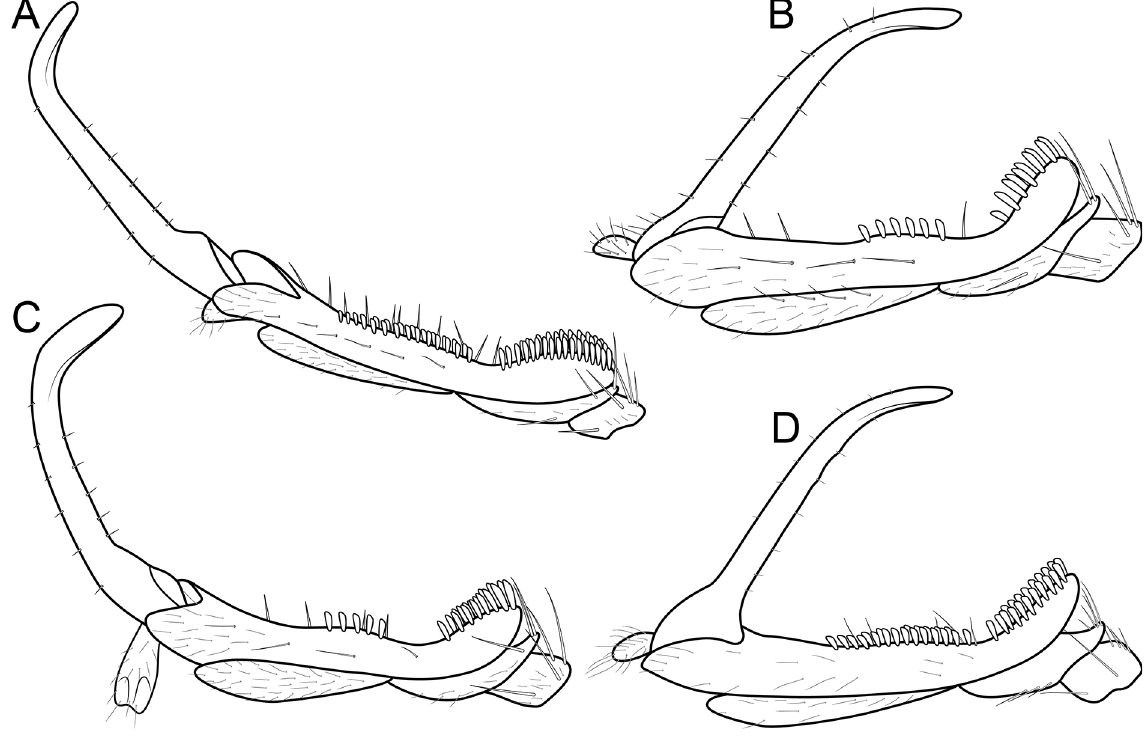
Fig. 10. Chela in lateral view of species of Pareucamptonyx Olmi, 1991. A . P . albopictus Martins sp. nov. B . P . kumagaiae Martins sp. nov. C . P . niger Martins sp. nov. D . P . paranaensis Martins